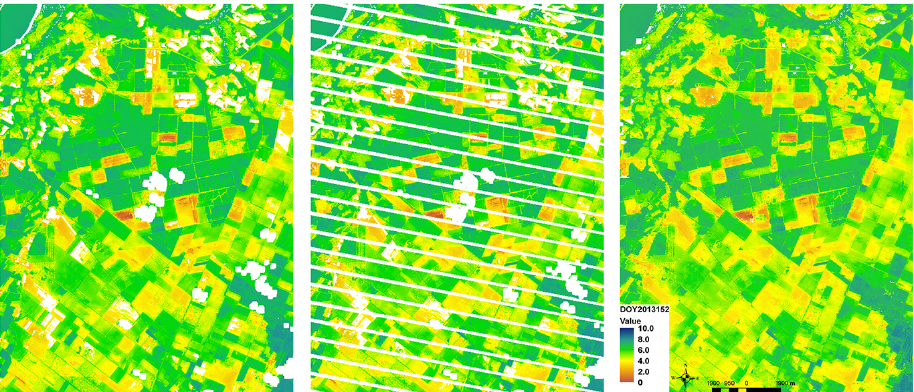
Figure 6. Comparison between the original Landsat ET retrieval for DOY 152 (left panel), an artificially gapped version, imposing SLC gaps from DOY 96 (middle panel), and the gap-filled map (right panel).